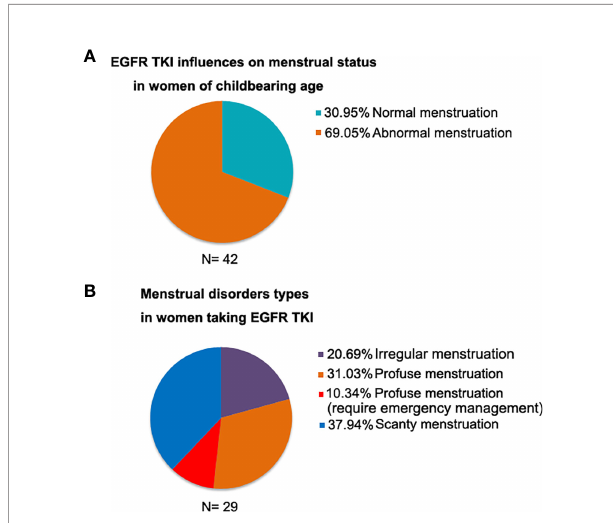
FIGURE 1 | The menstrual status in 42 premenopausal women during EGFR-TKI treatment. (A) 69.05% women experienced abnormal menstruation; (B) Among women with abnormal menstruation, 41.37% had profuse